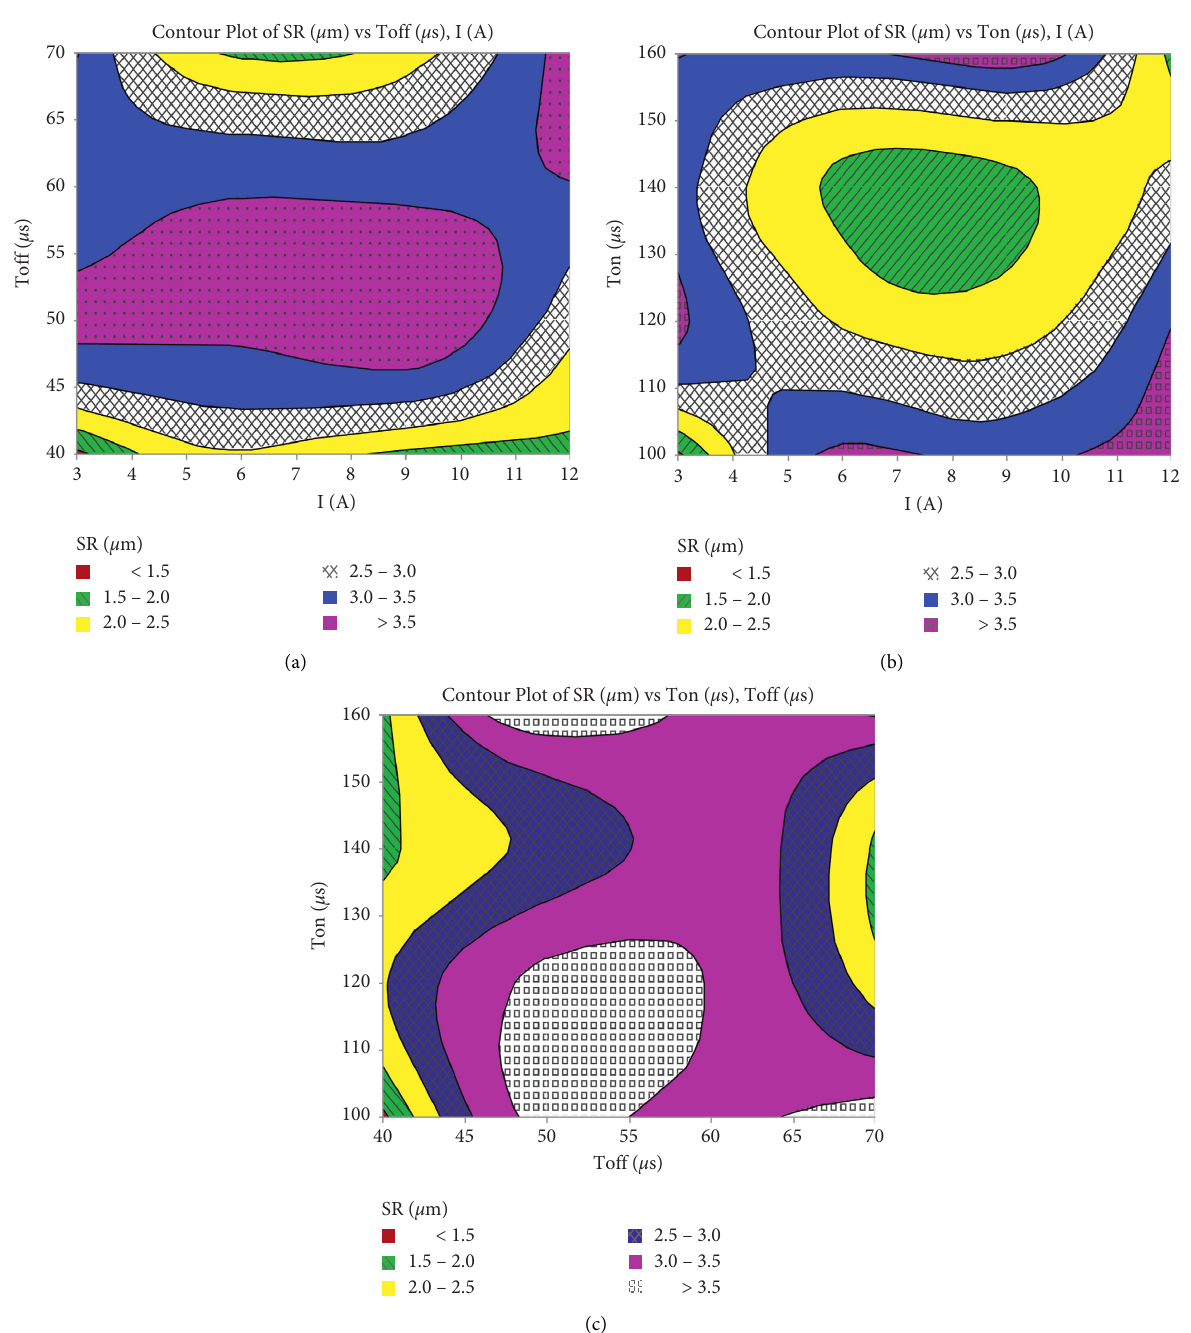
Figure 5: (a) Contour plot for SR I vs. T OFF . (b) Contour plot for SR I vs. T ON . (c) Contour plot for SR T OFF vs. T ON .